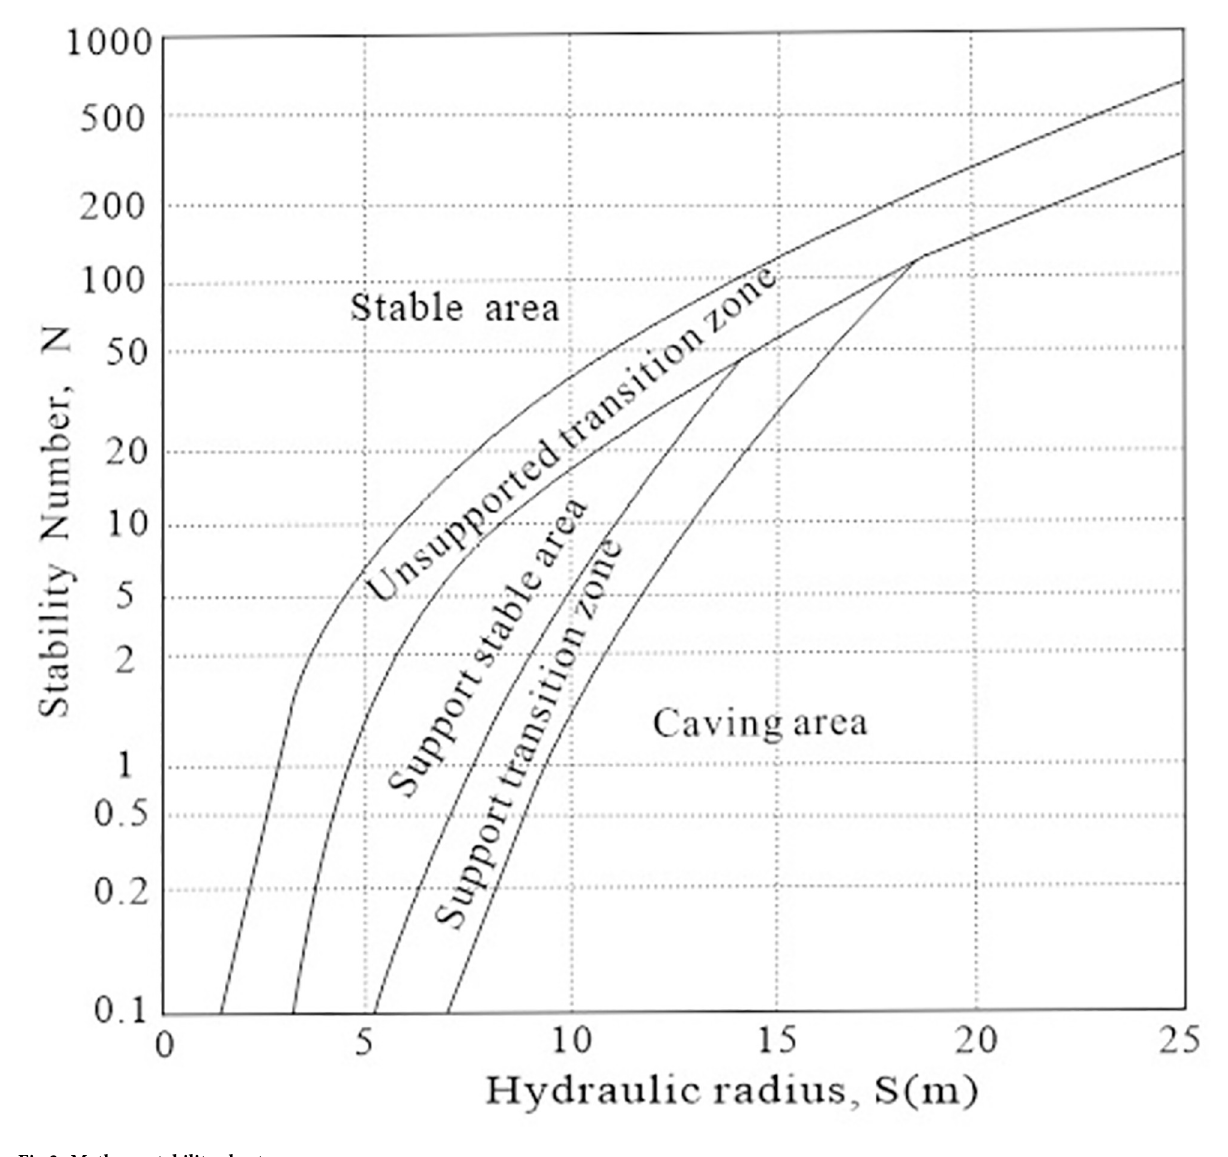
Fig 3. Mathews stability